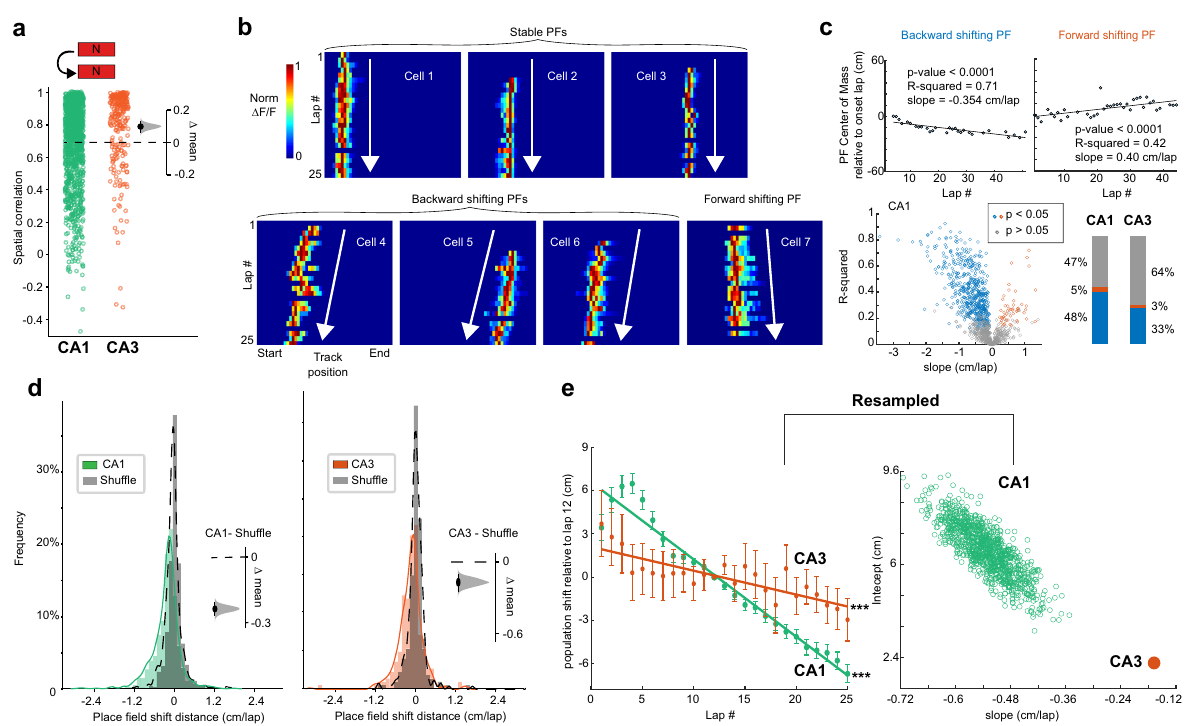
Fig. 3 CA3 place fi elds exhibit relative lap-by-lap stability while CA1 place fi elds shift with experience in novel environments. a Pearson ’ s correlation coef fi cient of all neurons with place fi elds within N (average activity map in fi rst 10 laps versus next 10 laps of session: CA1 n = 1238, CA3 n = 255 neurons). Bootstrapped mean difference ( Δ ) between CA1 and CA3 shown on the right. b Example place cells with stable or shifting place fi elds (PFs) in N (lap-by-lap activity for the fi rst 25 laps). White arrows depict the direction of shifting. c , Linear regression analysis on the center of mass (COM) of individual PFs (CA1 in N) shows a high number of signi fi cantly shifting PFs (blue and red dots and bars). The slope measures the direction and amplitude of the PF shift: for signi fi cantly shifting PFs, backward is blue, forward is red. CA3 has a lower proportion of signi fi cantly shifting PFs than CA1. d Histograms of the COM difference between last and onset laps ( fi ve-lap weighted average, see Methods) normalized by the number of laps for each PF in N for CA1 and CA3. Shuf fl ing the lap numbers (gray distributions) reveals an overrepresentation of backward shifting PFs, as con fi rmed by the bootstrapped mean difference ( Δ , insets). e Population shift of COM. Left, mean ±SEM, over all PFs, of fi ve-lap sliding average COM difference relative to lap 12 (see Methods), in N. CA1 (green) and CA3 (orange). Linear regression analysis (on all data points, not means) shows that the population of PFs shifts backwards signi fi cantly, both in CA1 and CA3. Linear regression, F test, *** P < 0.001, CA1, P < 1 × 10 − 100 , CA3, P = 1.3 × 10 − 4 . Right, The CA1 data set was resampled 1000x using n = 175 PFs to match the number of CA3 PFs and the slope and intercept of the regression line were measured each time (green dots). CA1 slopes are always steeper than the CA3 slope indicating that the CA1 population shifts signi fi cantly faster than